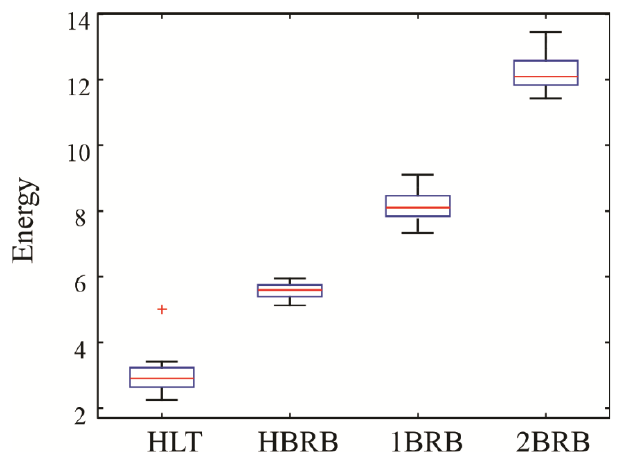
Table 4. Analysis of variance (ANOVA).